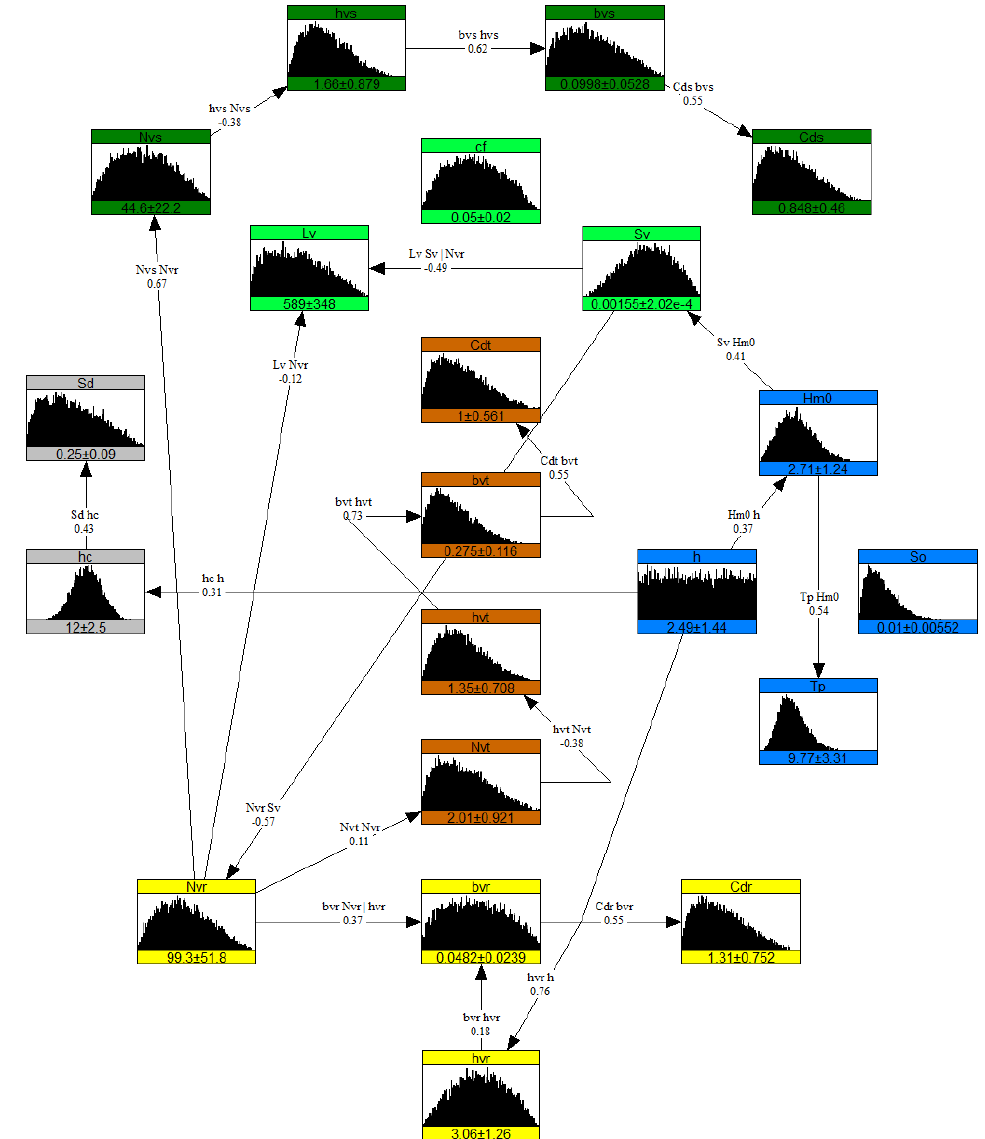
Figure 9. Nonparametric Bayesian network for mangroves environment. The boxes represent nodes (variables with their marginal distributions) and lines represent influences (correlations). Color indicates different components in the system: blue for hydrodynamics, gray for dike, light green for general vegetation variables, dark green for stems, brown for trunk, and yellow for roots of